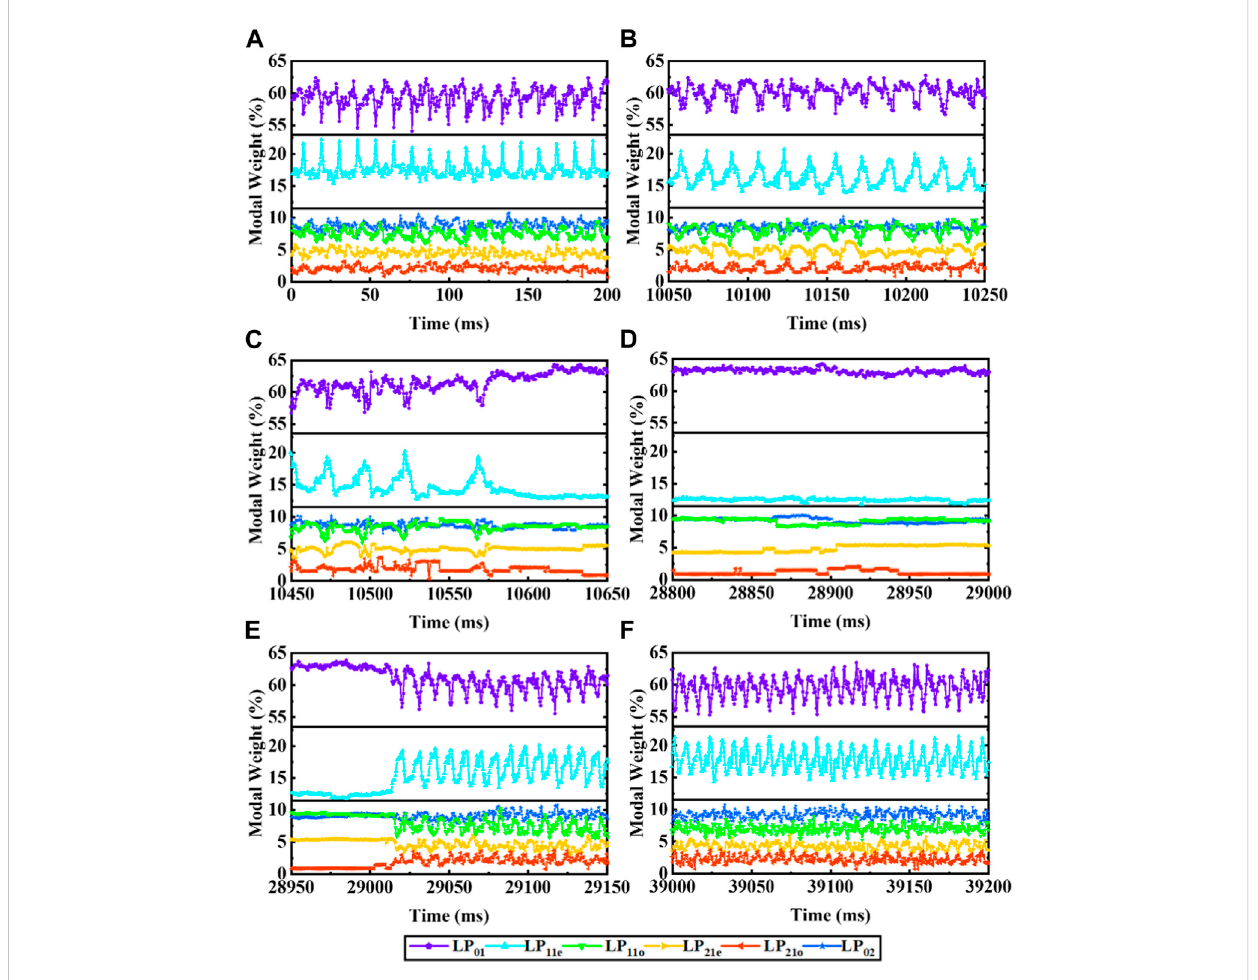
FIGURE 4 The variation of transverse mode coupling at the pumping power of 357